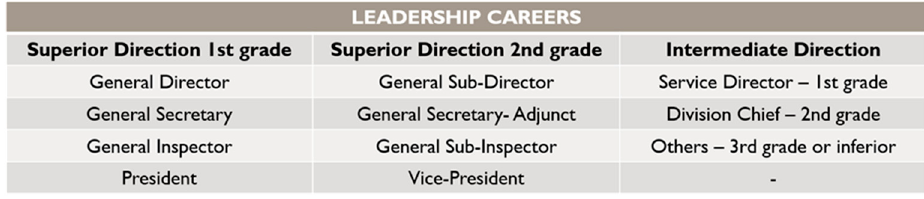
Figure 3. Leadership Careers. Source: DGAEP—2022.